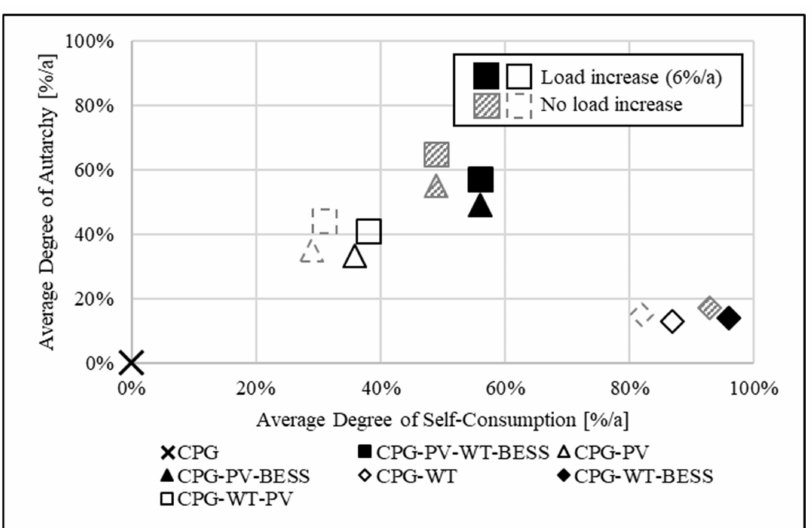
Figure 4. Comparison of the average degree of self-consumption and autarchy with and without demand-increase in the energy system scenarios based on the NESSI4D